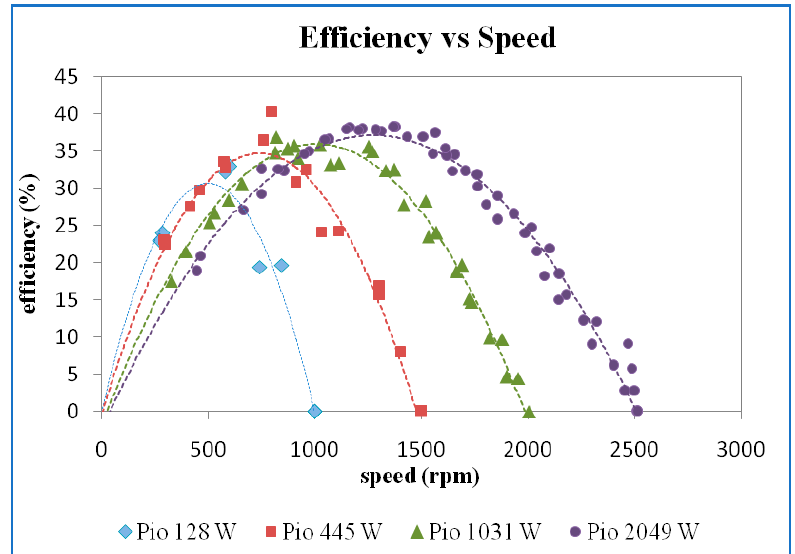
Figure 10. Efficiency vs. speed at a guide vane opening of 10 mm.